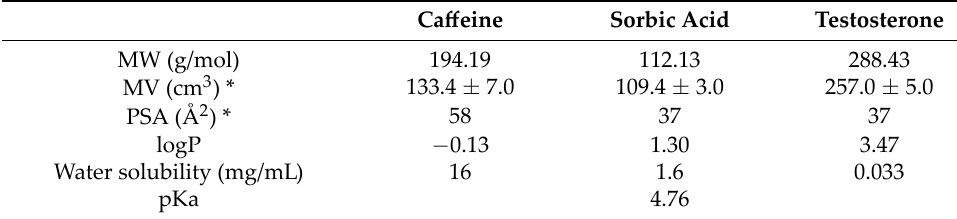
Table 2. Physicochemical properties of the studied substances. Caffeine Sorbic Acid